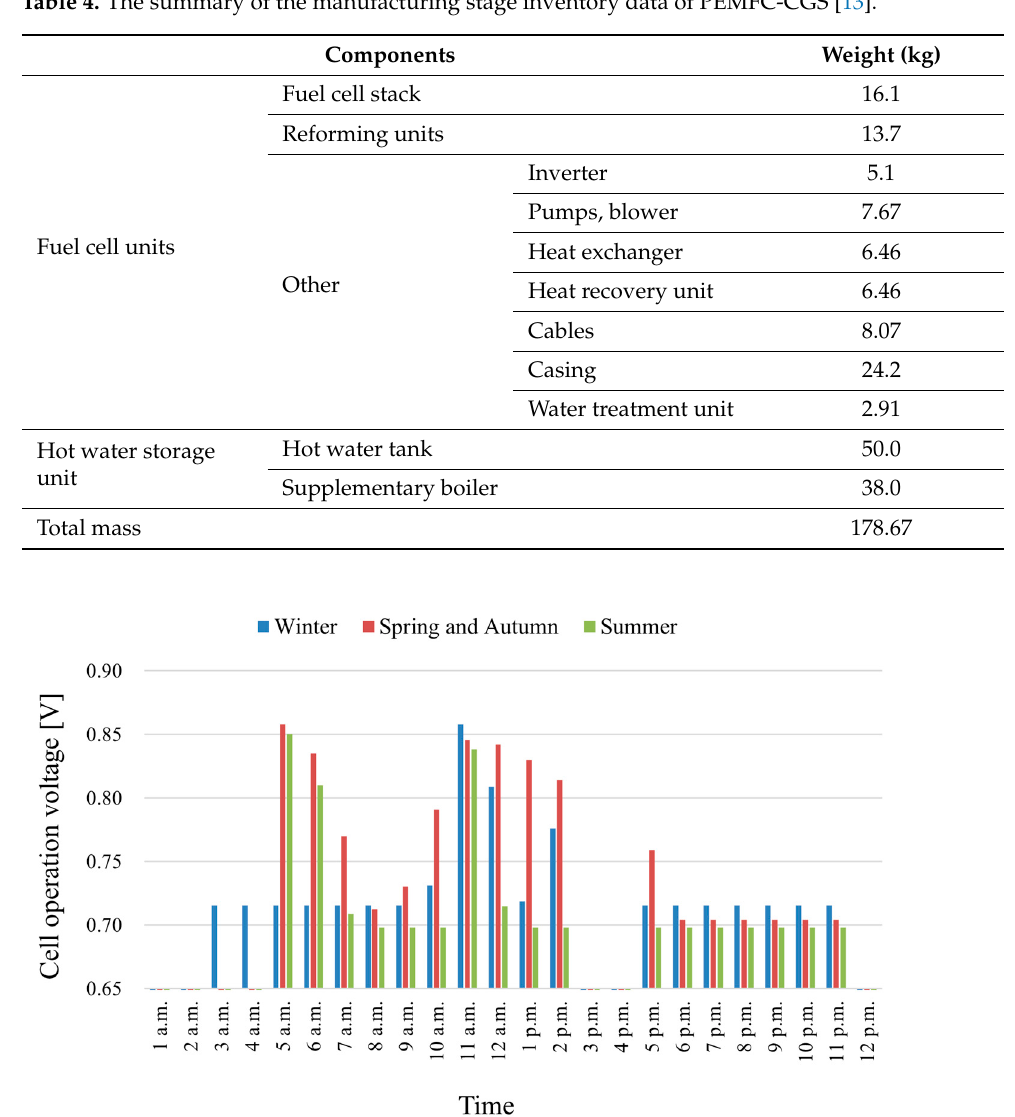
Table 4. The summary of the manufacturing stage inventory data of PEMFC-CGS [13].